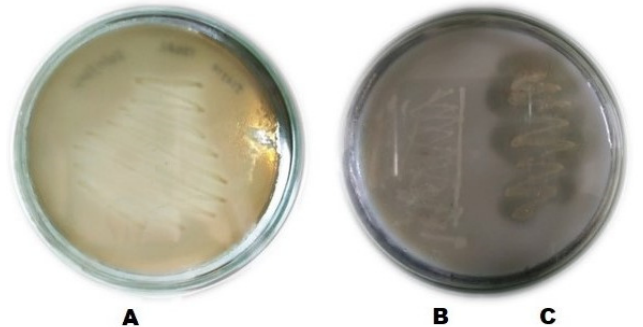
Figure 2. Growth of PKI7 (A) and PKI8 (C) on tannic Acid agar medium showing zone of tannin hydrolysis after 24 h of incubation; while B showing tannin tolerant bacteria